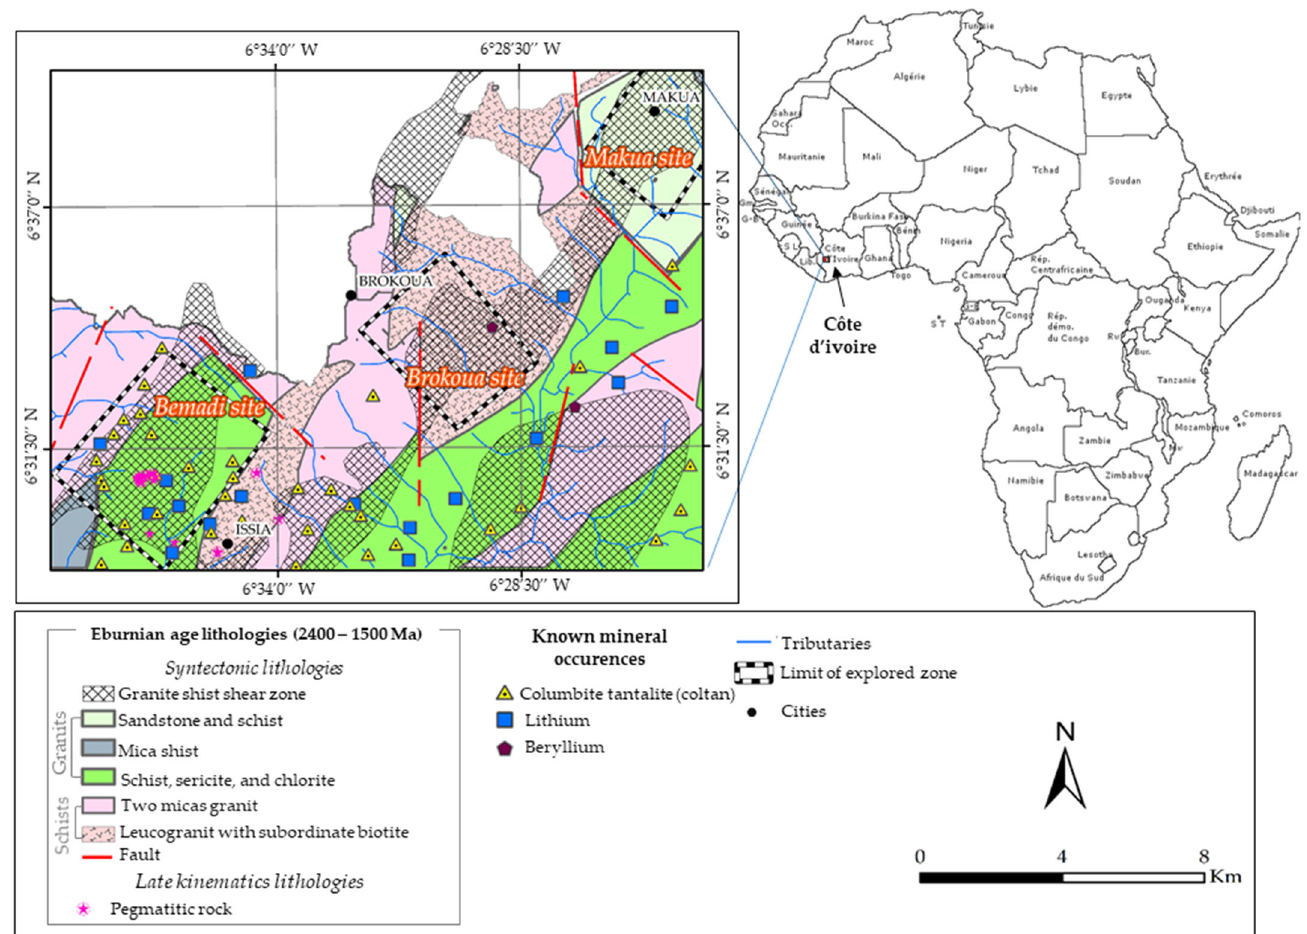
Figure 1. Location of the study area with regard to the granite schist shear zone (by Cruys, 1965) [25] (map of Africa source: © mappemonde.net, (accessed on 18 October 2022)).